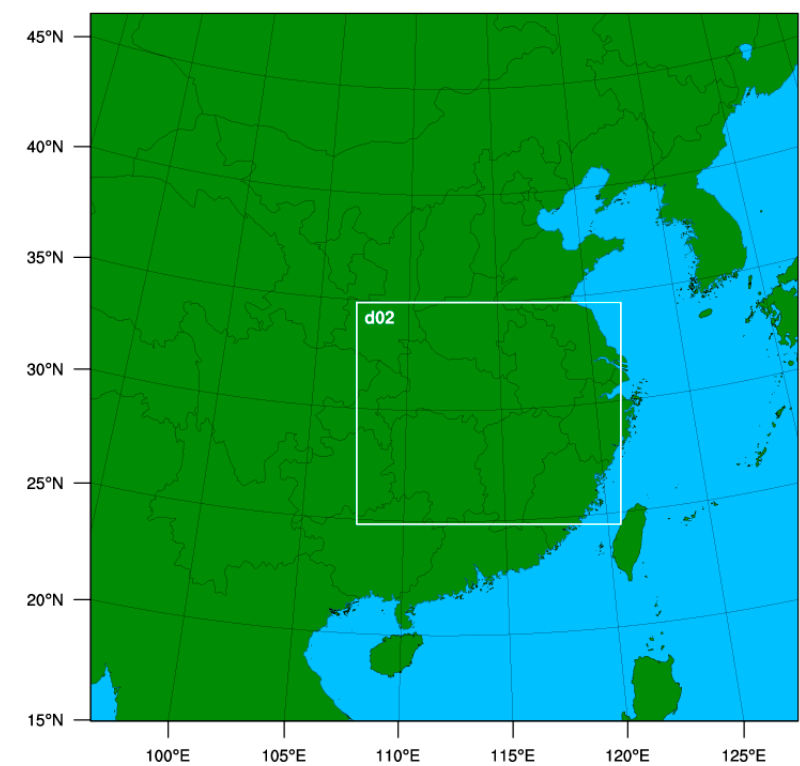
Figure 4. Nested Weather Research and Forecast (WRF) model domain configuration. See text for details.